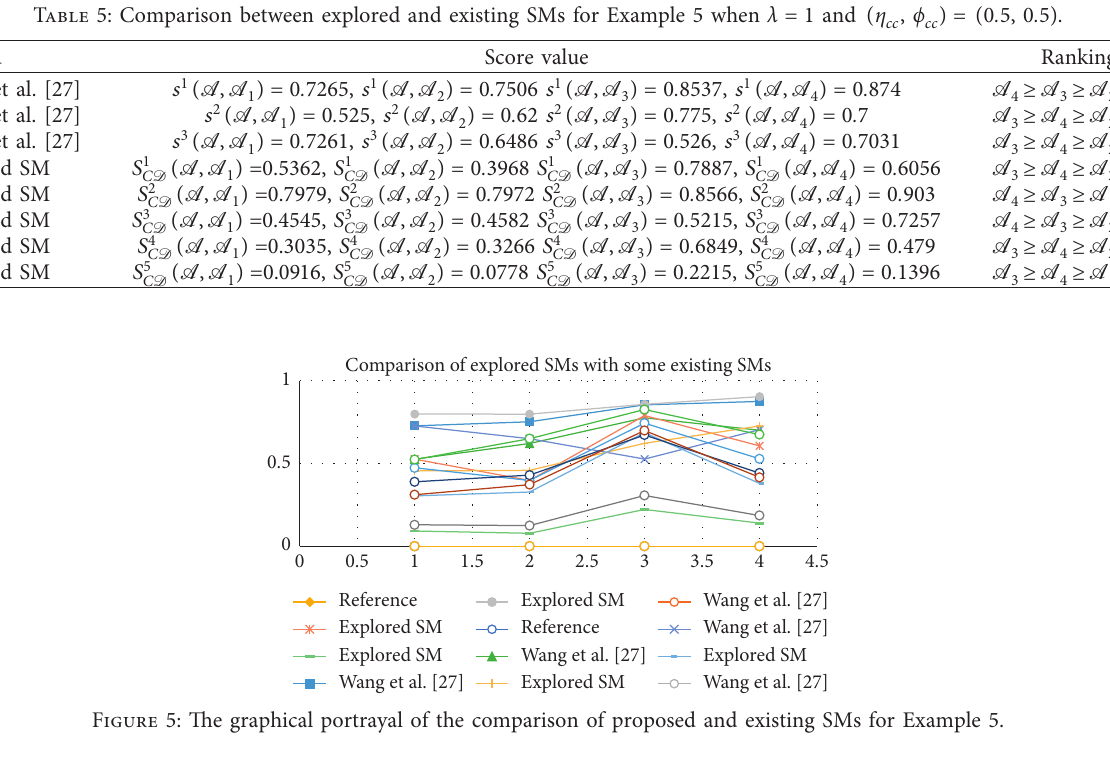
Table 6: Comparison between explored and existing SMs for Example 3 when λ � 1 and ( η Method Score value Ranking Wang et al. [27] Failed Failed Wang et al. [27] Failed Failed Wang et al. [27] Failed Failed Explored SM